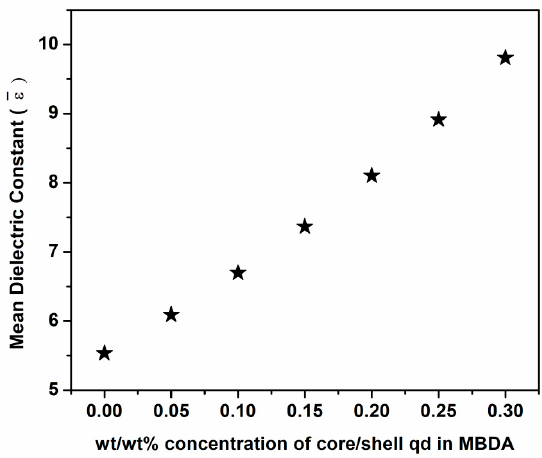
Figure 8. Mean dielectric constant of pure nematic MBDA and its mixture with core/shell quantum dots (Mix 1 to Mix 6) at a 1 kHz frequency.